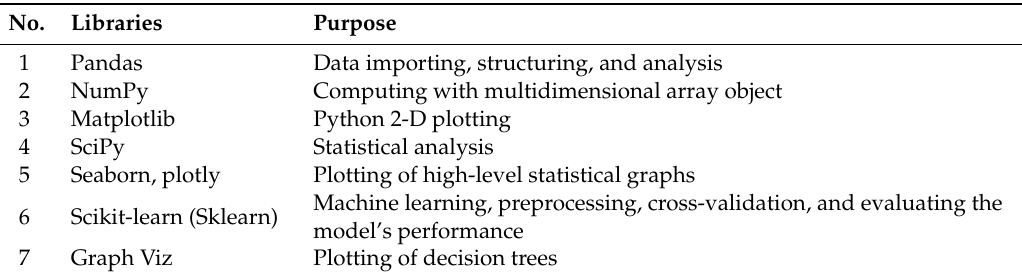
Table 5. Python libraries for data processing